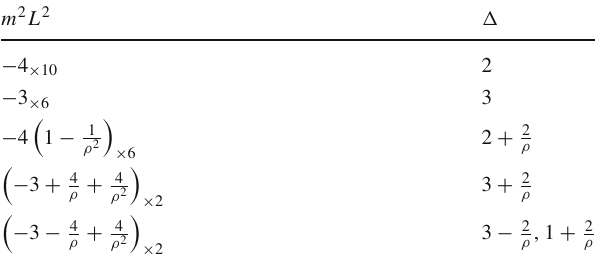
Table 1 Scalar masses at the N = 4 supersymmetric AdS 5 critical pointIwith SO ( 2 ) D × SO ( 3 ) × SO ( 3 ) symmetryandthecorresponding dimensions of the dual operators